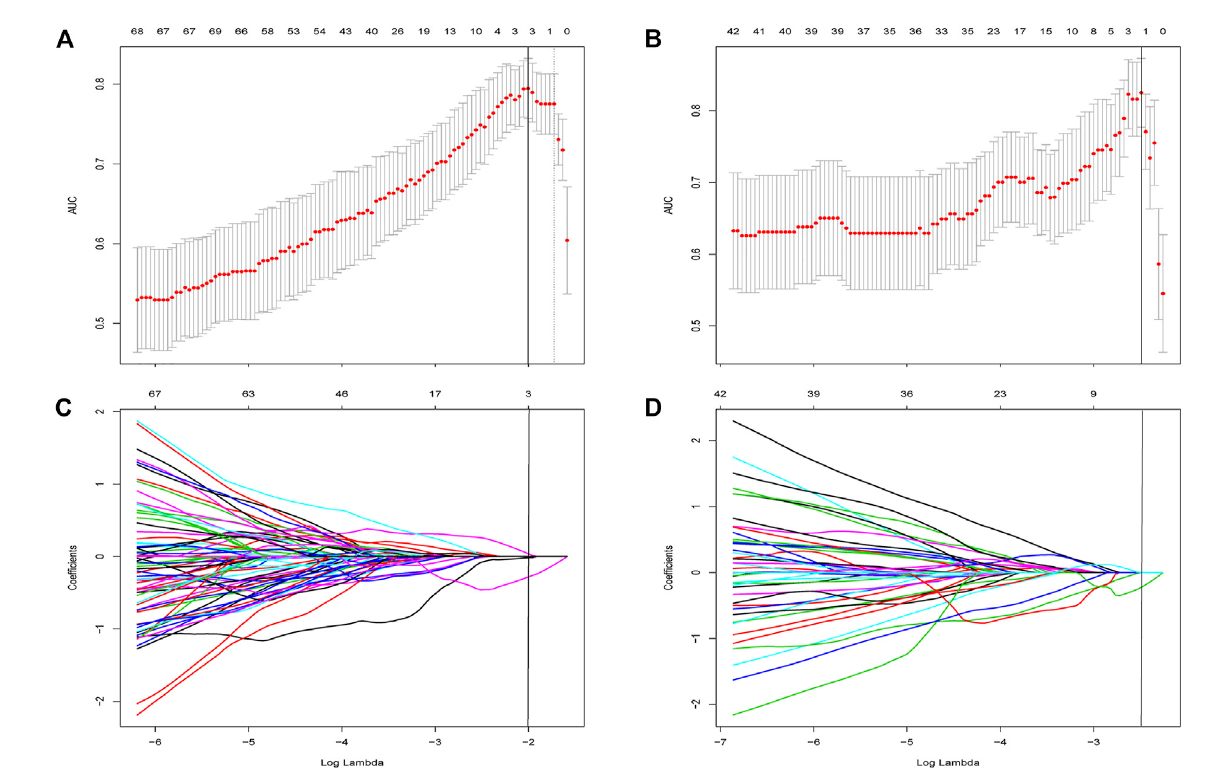
FIGURE 3 Feature selection using the least absolute shrinkage and selection operator (LASSO) regression within features extracted from liver. (A) Selection of tuning parameter ( λ ) was determined by the LASSO model using 10-fold cross validation via minimum criteria. The AUC curve was plotted versus log ( λ ). Dotted vertical lines were drawn at the optimal values by using the minimum criteria and the 1 standard error of the minimum criteria (the 1 — Standard error criteria). The optimal λ value of 0.135 with log ( λ ) of − 2 was chosen in Group One. (B) Feature selection in Group 2 and the optimal λ value of